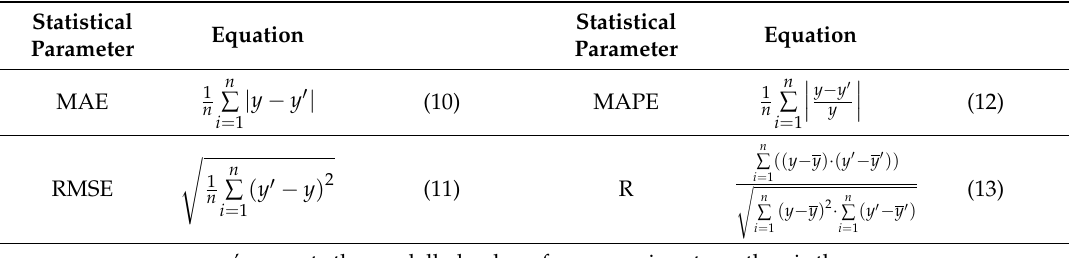
Table 7. Statistical performance measures.